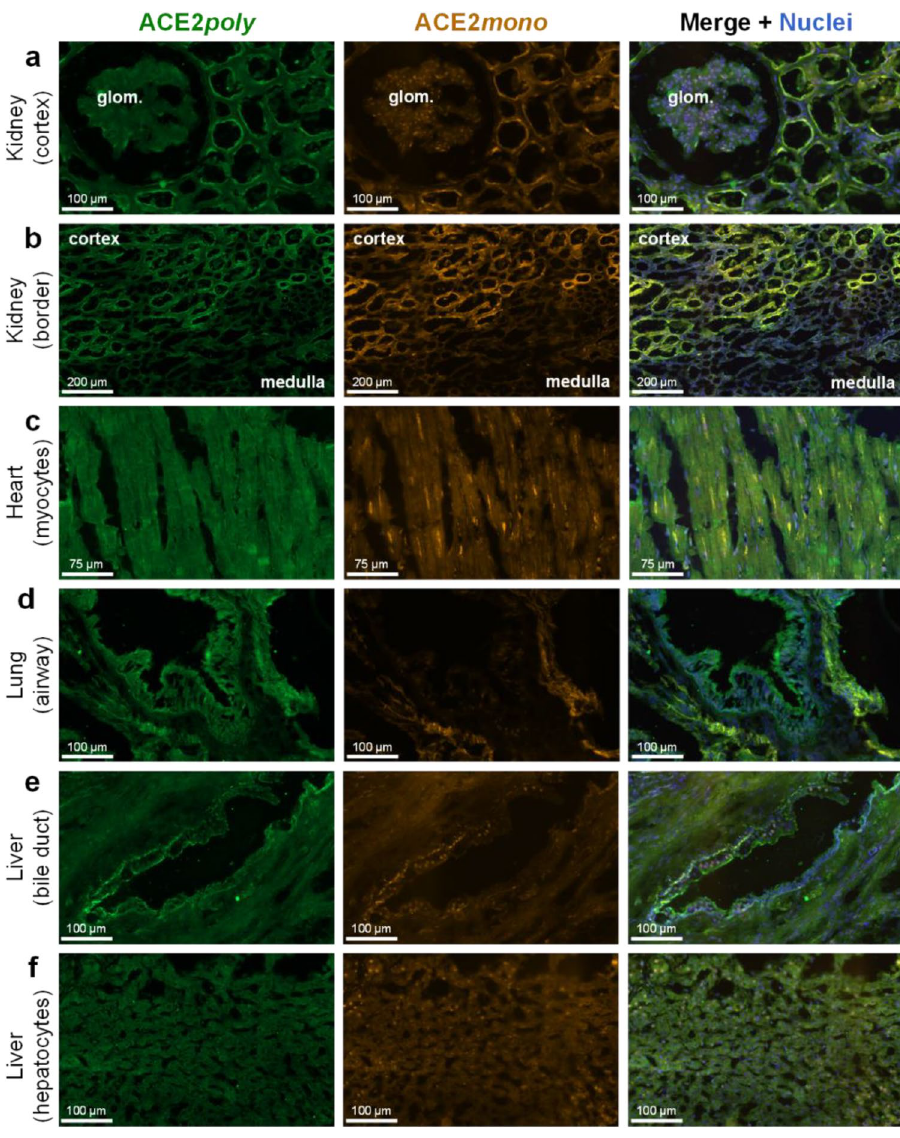
Figure 3. Differential expression of full-length ACE2 and the short dACE2 isoform in a panel of human tissues. Representative fluorescent images (n = 3 independent donors, stained in duplicate) of human tissue fixed in 4% formaldehyde and treated with ACE2 poly (left column, visualised in green) and ACE2 mono (centre column, visualised in orange). Merged images (right column, overlay) also include Hoechst 33342 nuclear marker (visualised in blue). Scale bars are as indicated in figure. Tissues shown include: ( a ) Kidney cortex, with a glomerulus (glom.) indicated; ( b ) Kidney border, showing a region where tubules of the cortex meet tubules of the medulla; ( c ) Heart tissue, showing cardiomyocytes; ( d ) Lung tissue, showing an airway structure; ( e ) Liver bile duct; ( f ) Liver